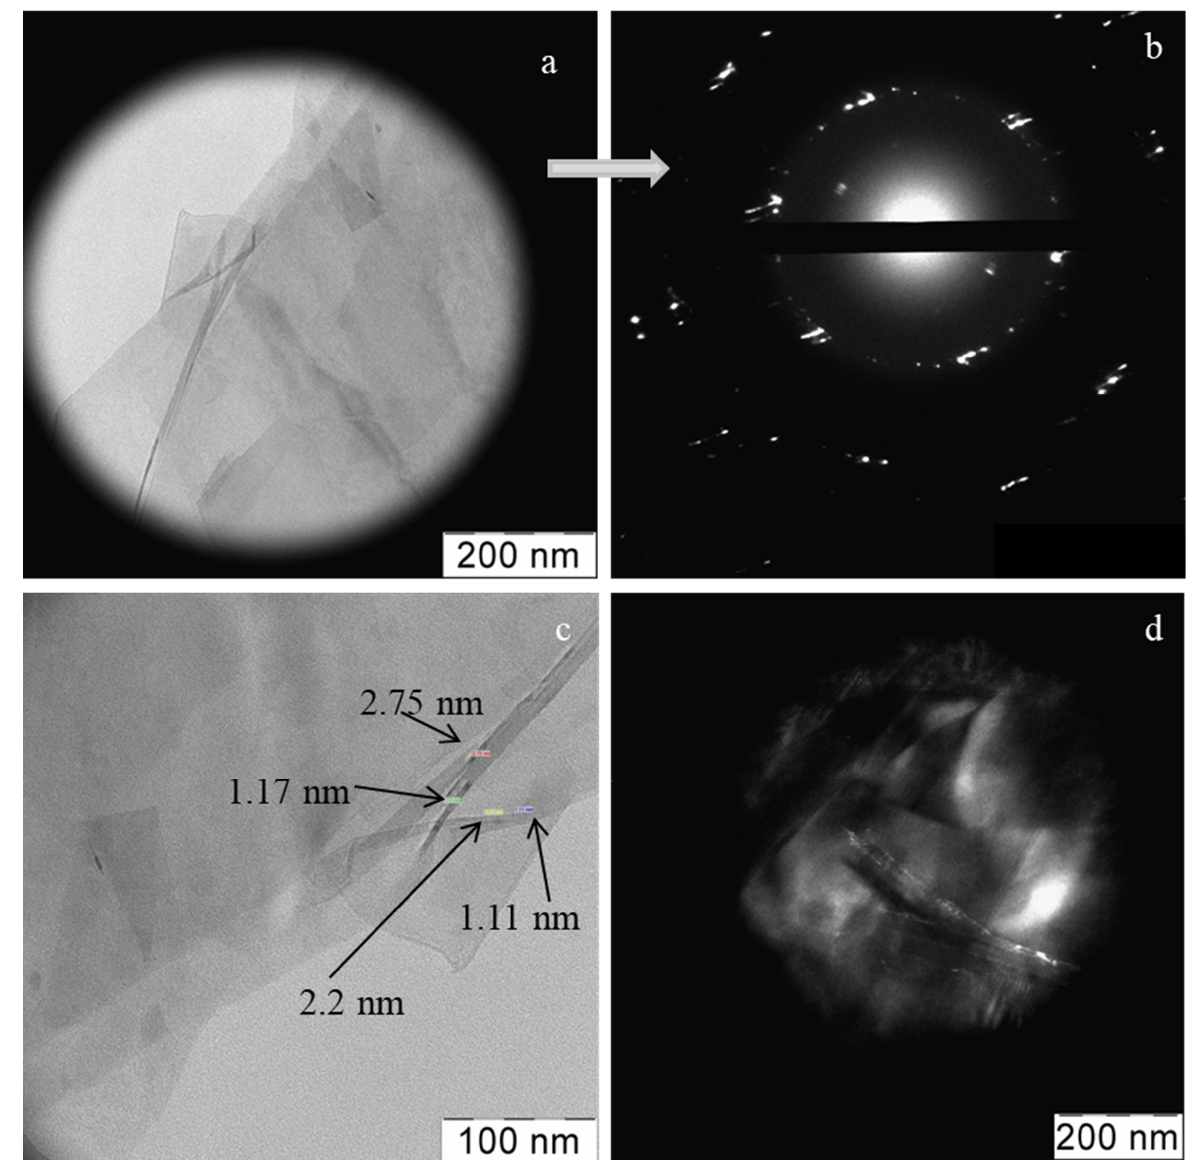
Figure 3. TEM data for a graphene suspension in isopropanol: a package consisting of sheets ( a ); electron diffraction in the area shown in subfigure ( a , b ); the double thickness of the graphene sheets on the folds ( c ), the dark-field image shows the moir é pattern on the graphene ( d